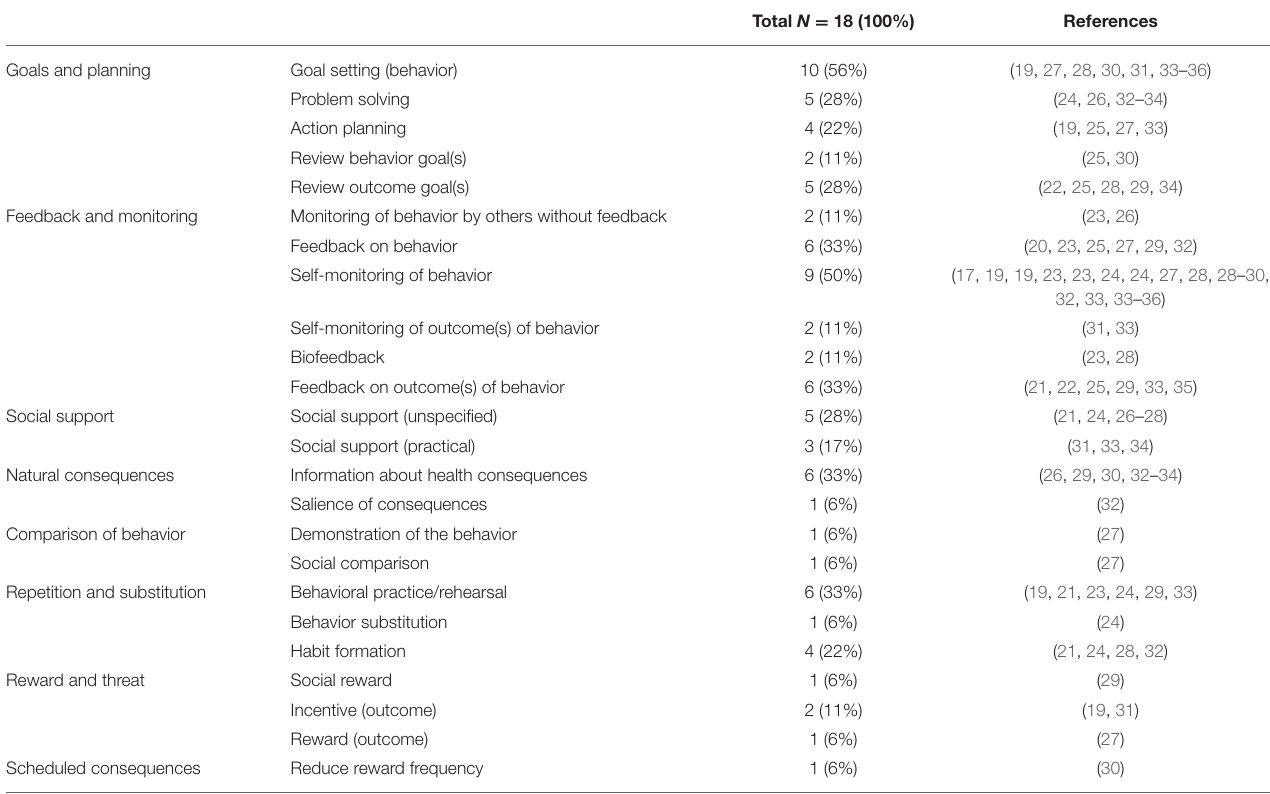
TABLE 3 | Behavior change technique used in the selected